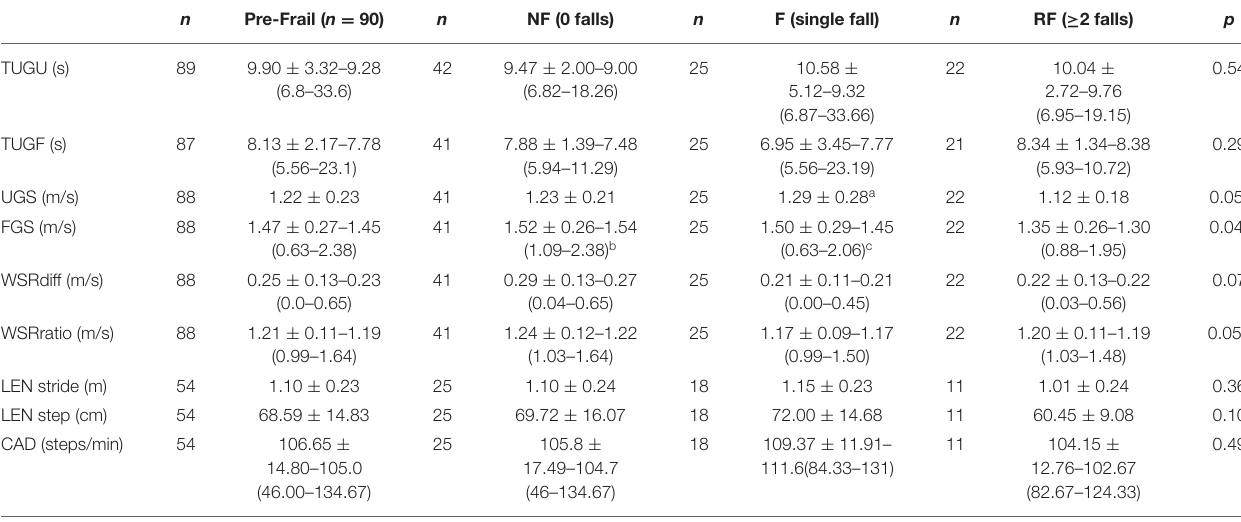
TABLE 2 | Characterization and comparison of the functional performance of pre-frail non-fallers, fallers, and recurrent fallers older